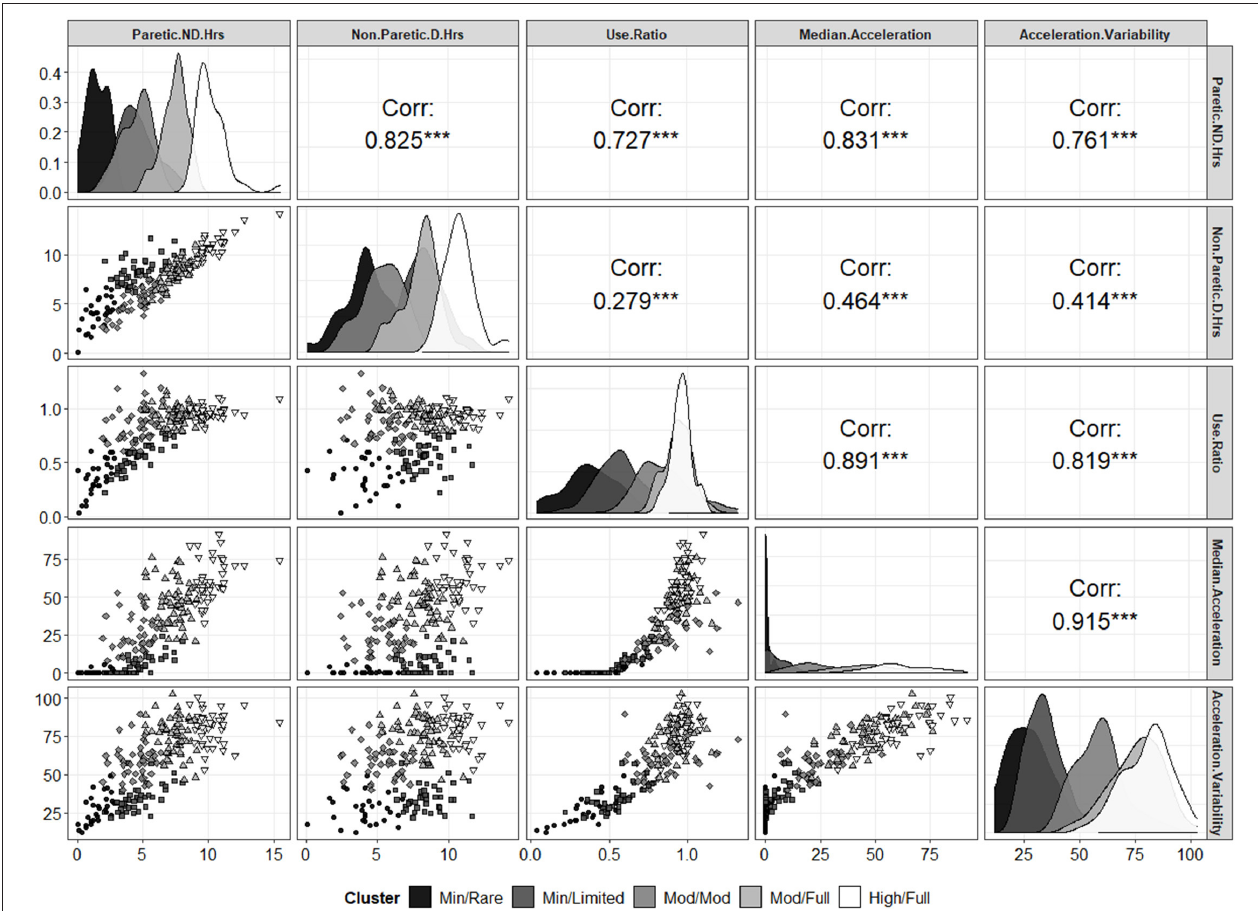
FIGURE 2 | Scatterplot matrix of the 5 input variables as a function of the 5 different clusters. The diagonal shows density plots (i.e., the univariate distribution) of each input variable as a function of the different clusters. The lower left panels show the bivariate distributions for each pair of variables with the point shapes and gray scales corresponding to the different clusters (see legend). The upper right panels show the Spearman rank order correlations for each pair of variables (on the whole, ignoring clusters). *** p < 0.001.